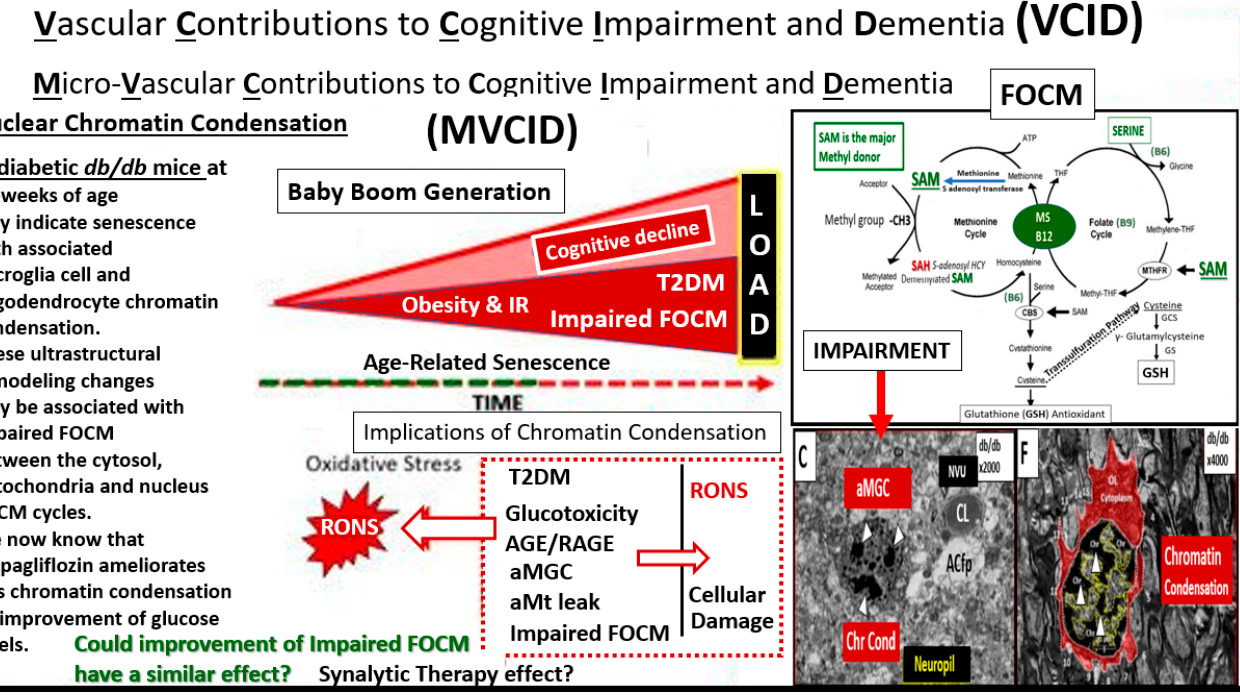
Figure 9. Vascular Contributions to Cognitive Impairment and Dementia (VCID), LOAD and FOCM. Our current society is aging, especially in the group referred to as the baby boom generation and age-related senescence. The aging society including the baby boomers is at a much higher risk for cerebro-cardiovascular disease and stroke especially with their comorbidities of aging such as hypertension and type 2 diabetes (T2DM). This slide focuses on T2DM, LOAD and age-related se- nescence that is ongoing as our population ages. This image does not portray inflammation; how- ever, it is strongly related to an excess of RONS generated by aging, T2DM, LOAD. This figure points out the nuclear chromatin condensation of the amoeboid, aberrant and activated microglia